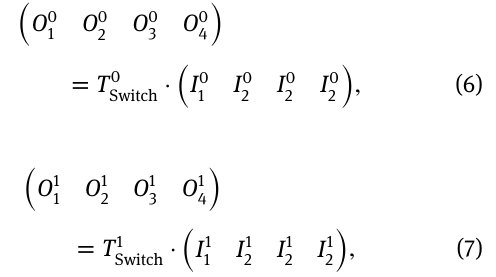
as I i0 and I i1 by the mode demultiplexer,